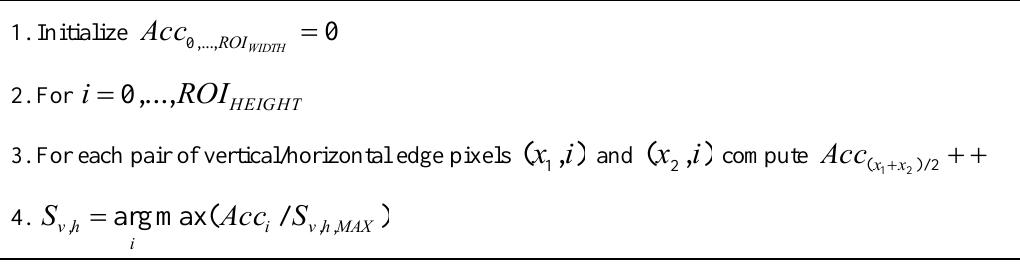
Figure 6. Vertical and/or horizontal edges symmetries computation procedure.